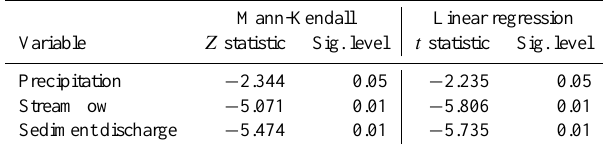
Mann-Kendall Linear regression Variable Z statistic Sig. level t statistic Sig.